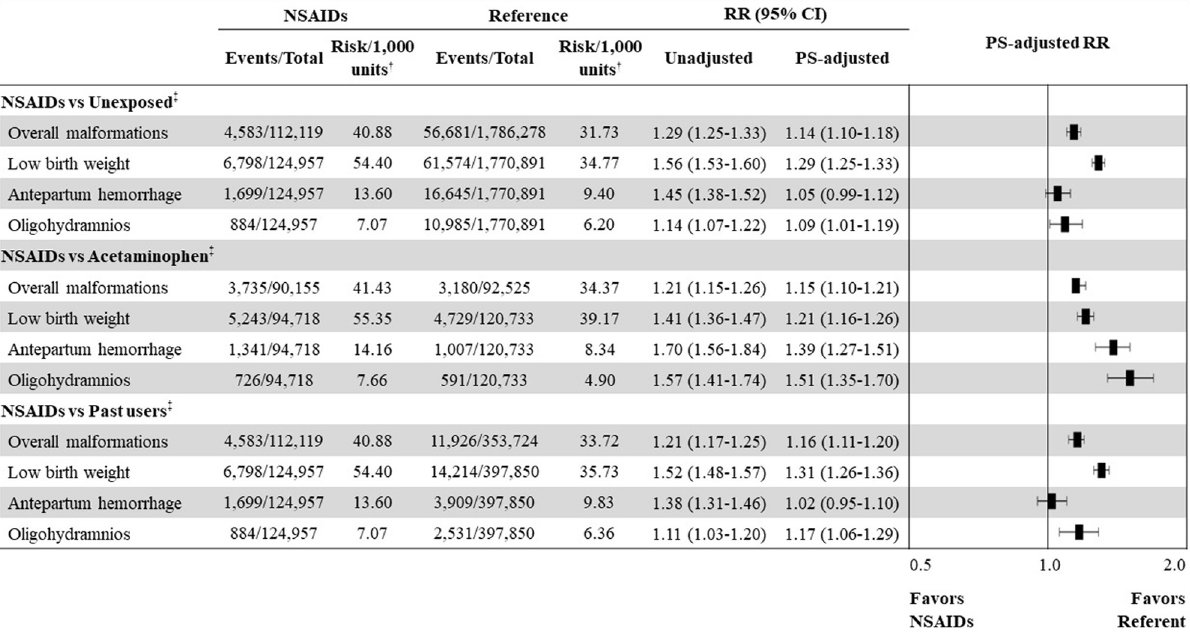
Fig 2. Risk of neonatal and maternal adverse outcomes associated with NSAID exposure during the first trimester or early pregnancy compared with three distinct referent groups. CI, confidential interval; NSAID, nonsteroidal anti-inflammatory drug; PS, propensity score; RD, risk difference; RR, relative risk. � RD 1,000 = risk difference per 1,000 births or pregnancies. † Units: births for outcomes of overall congenital malformations and low birth weights; pregnancies for outcomes of antepartum hemorrhage and oligohydramnios. ‡ Associated risk of major congenital malformations and other adverse outcomes in women who used NSAIDs in early pregnancy was compared with three distinct pregnancy groups: women not prescribed any NSAIDs (unexposed), women prescribed � 2 acetaminophen (acetaminophen), and women who stopped taking NSAIDs during pregnancy but were prescribed them before (past